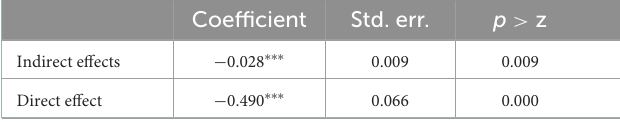
TABLE 3 Decomposition of the effect of urban and rural areas on mental health.